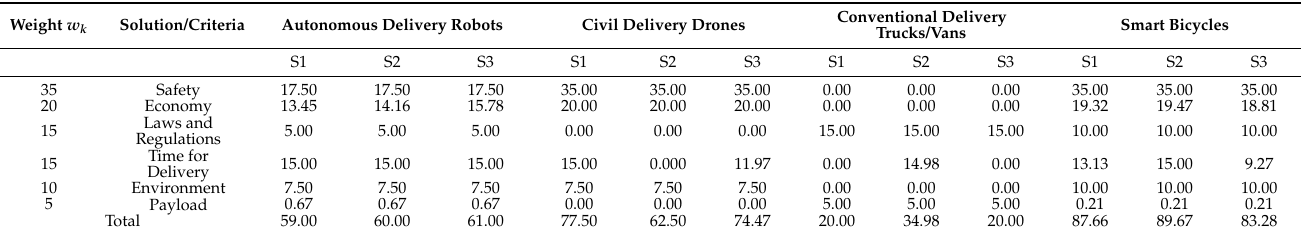
Table 11. Total scores, point allocation method.